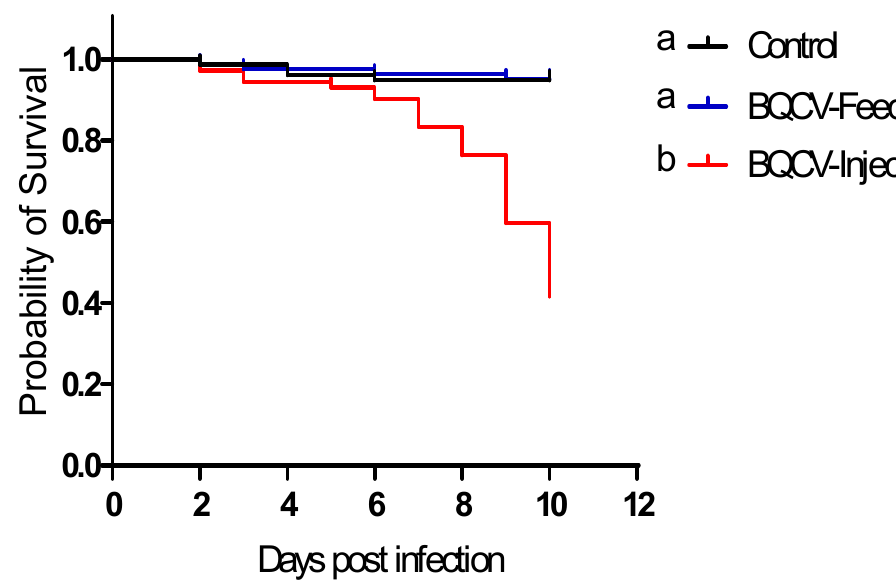
Figure 1. Survival of honey bees treated with Black queen cell virus (BQCV). Bees were either injected with one µL inoculum containing 10 8 BQCV or fed 10 µL of sugar syrup containing 10 8 BQCV on day 0. Controls received the same treatments devoid of virus. Different lower case letters indicate statistically significant differences between treatments (Log-rank (Mantel-Cox), p < 0.05).